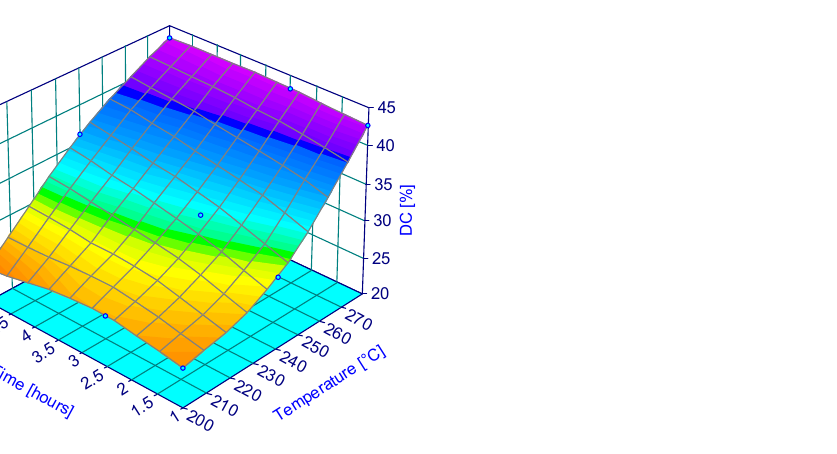
Figure 3. Response surface plot showing the effect of temperature (°C) and residence time (h) on the SB conversion degree (solid-to-liquid ratio of 1/5).